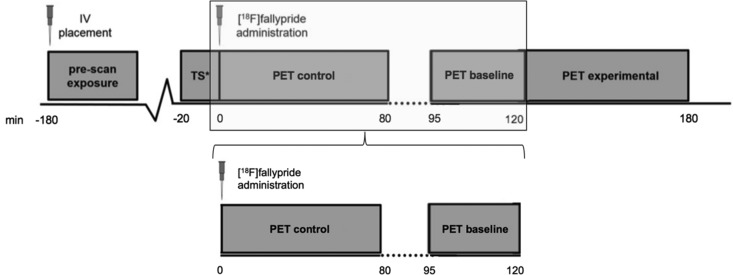
PET acquisition protocol. The original PET acquisition protocol. In gray, the part of the PET acquisition protocol used for analyses in this study is highlighted. *TS = 68Ge/68Ga-transmission scan, timeline in minutes. PET control: Sensori-motor control condition: Participants conducted a sensori-motor control condition prior to the baseline and experimental condition (previously described in Kasanova et al., 2017, 2018). This condition was designed to contain all features of the task of the experimental condition, without the main manipulation of the experimental condition; outcome-based associative learning. This control condition was presented on a 30-inch screen placed in the field of view of the participant. Similar to the experimental condition, images of a stimulus (photographs of actors) appeared on the screen and participants had to choose between one of two items depicted under the stimulus, for instance, indicate whether the actor was male or female, had short or long hair. The participant was instructed before the task that there was no right or wrong answer. No feedback was provided during the task. The control condition consisted of six blocks of 120 trials, in which 18 actors were presented 40 times, lasting approximately 10 min per block with intertrial intervals where the previous stimulus and items were still visible on the screen for 4 s. The sensori-motor control scan lasted 80 min and consisted of a total of 36 frames (6 × 60 s frames + 30 × 120 s frames). PET baseline condition: During the baseline condition the participants were instructed to lay down and rest in the scanner. The baseline scan lasted 25 min and consisted of 18 (120 s) frames.